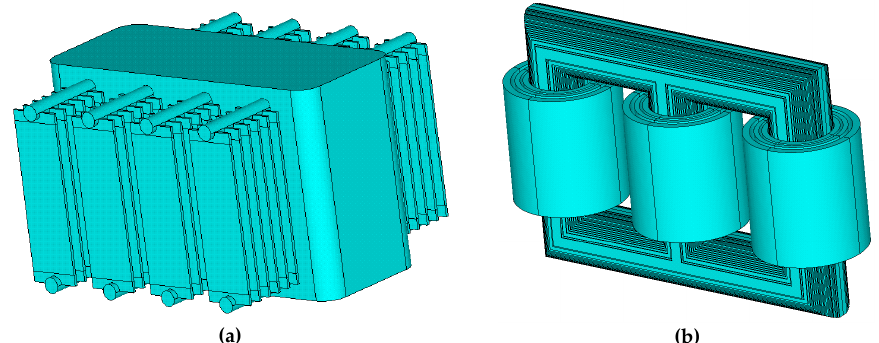
Figure 5. ( a ) Three-phase three-limb transformer model (external) and ( b ) Three-phase three-limb transformer model (internal).